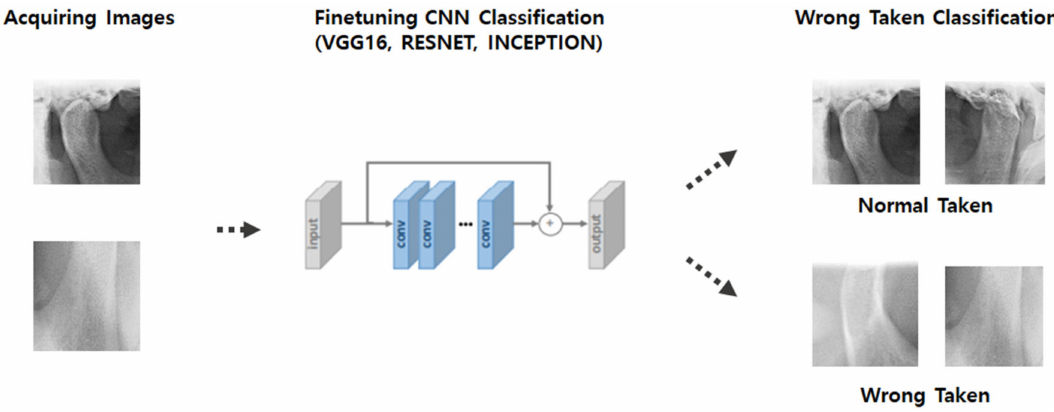
Figure 4. Condyle validity classification model.